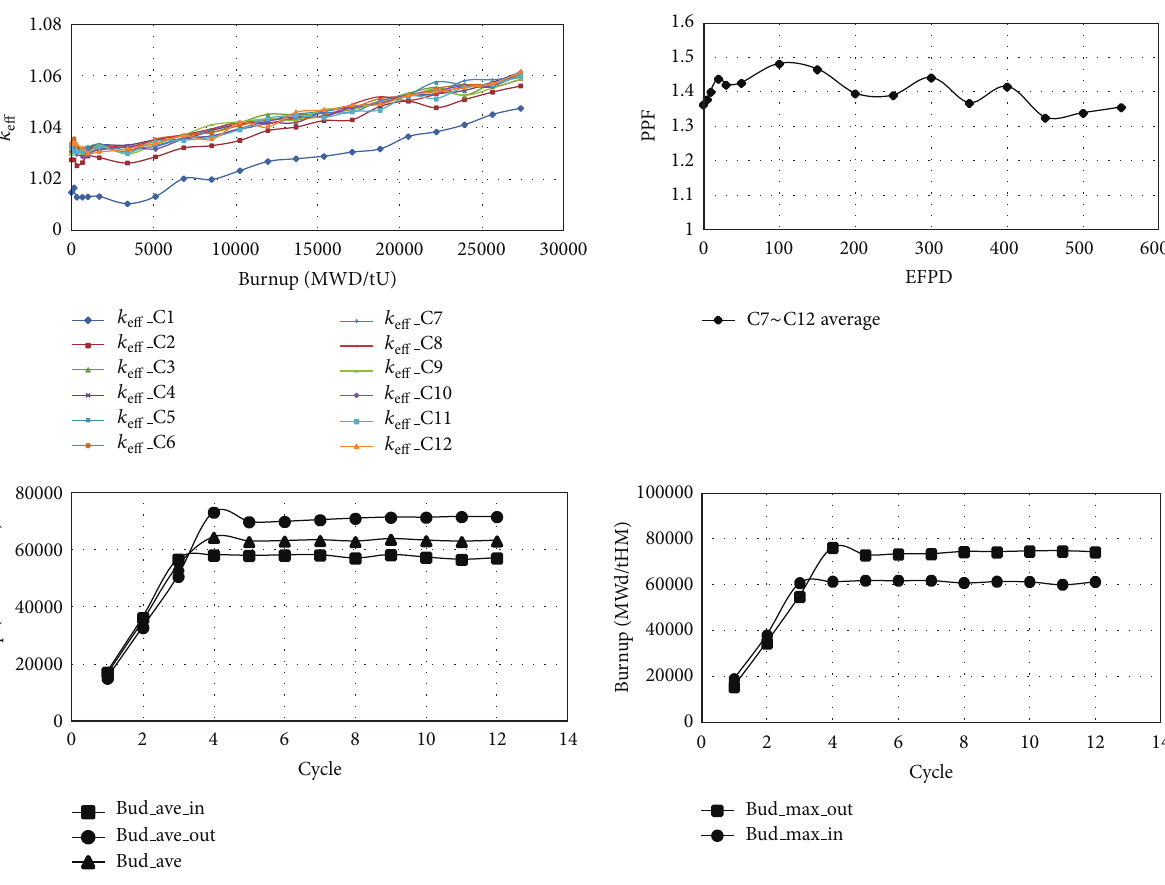
Figure 11: Multicycle burnup simulation results for Th-MOX